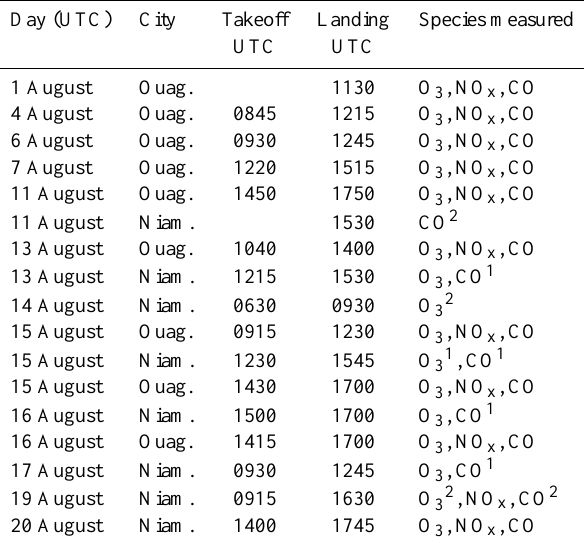
Table 2. List of the flights near Niamey (Niam.) and Ouagadougou (Ouag.).